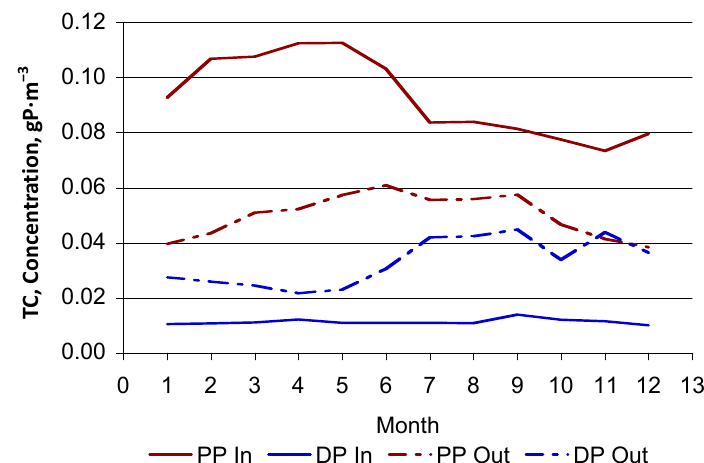
Figure 6. Monthly performance of the ENRP over a four-year POR. The average hydraulic loading was 2.4 cm/day. PP (particulate) and Dissolved phosphorus (DP) are reduced in all months. Overall TP reduction is slightly less in the first six months of the year (73%) and slightly greater in the second six months (82%).